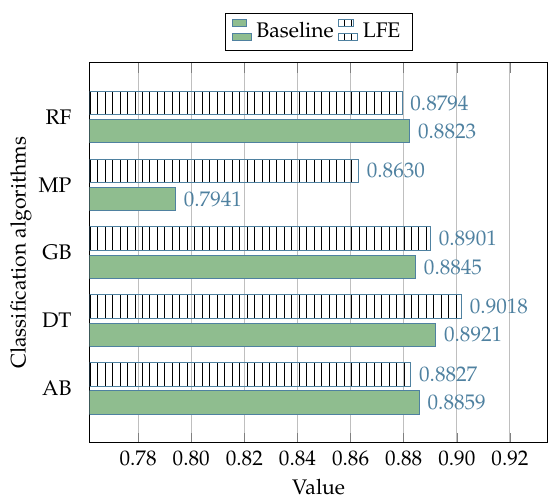
Figure 9. NSL-KDD dataset—AUC mean performance.